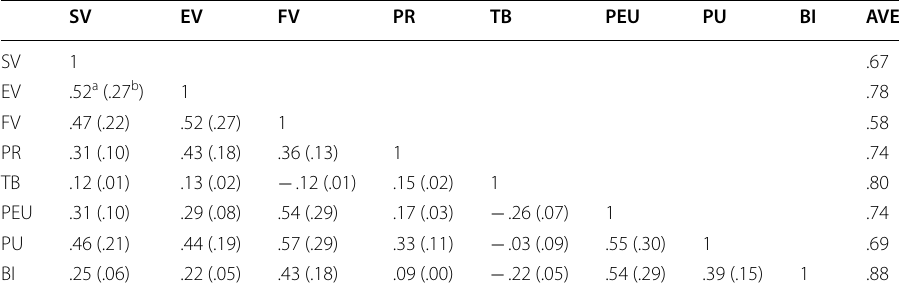
a Correlation coefficient b Squared correlation coefficient